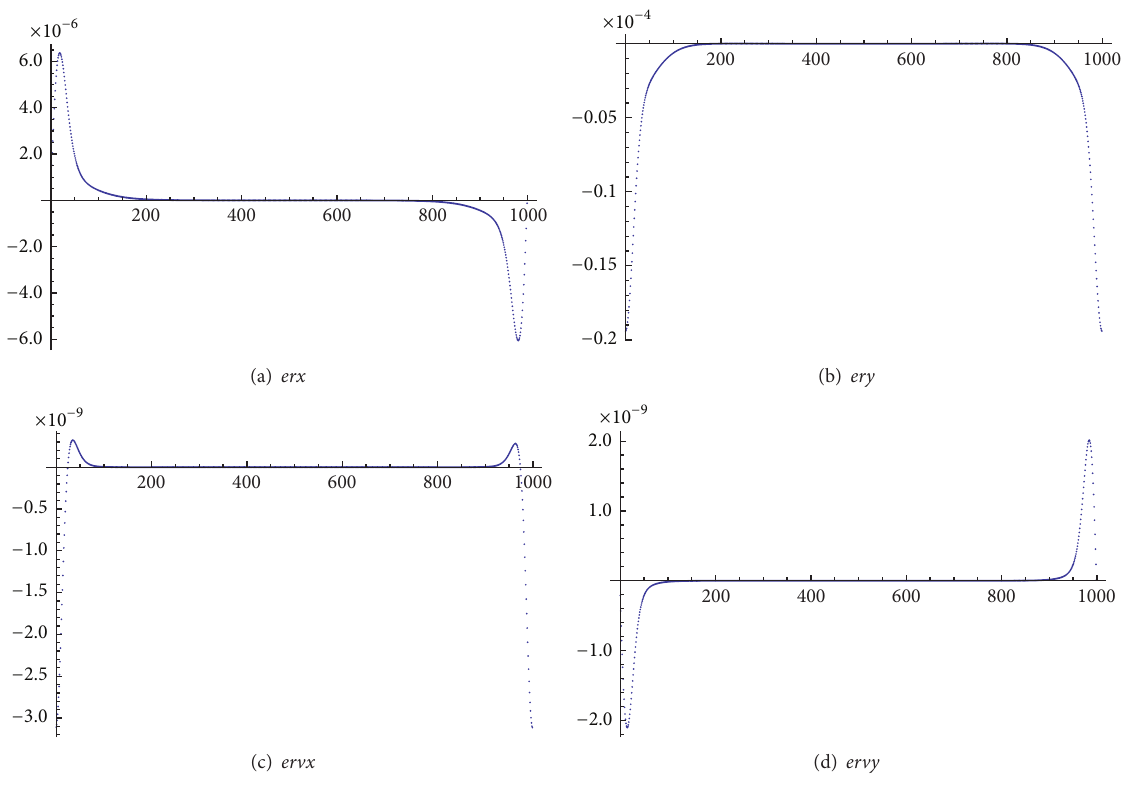
Figure 4: Local integration errors distribution 𝑒 = 0.7 , 𝛼 = 0.0 .